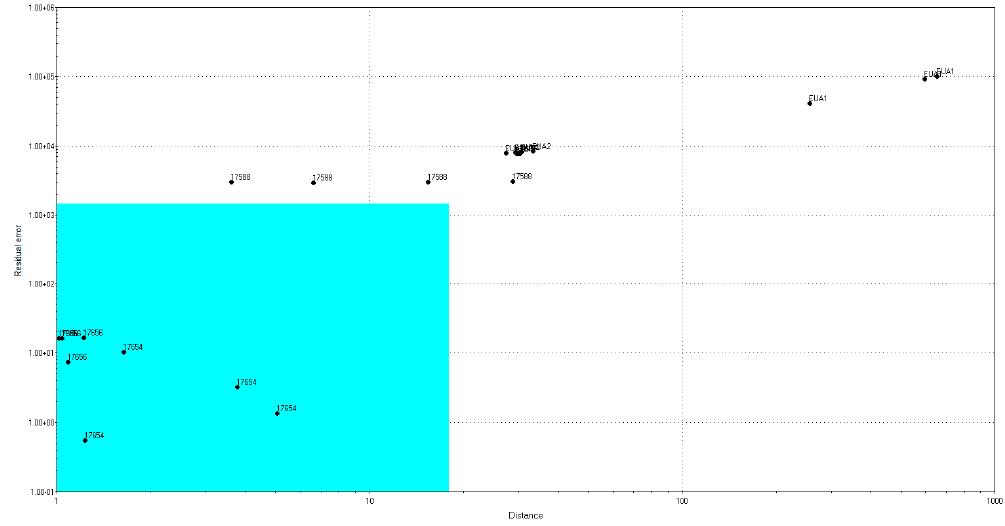
Figure 4. Soft Independent Modeling Class Analogy (SIMCA) model for Eucalyptus honeys.